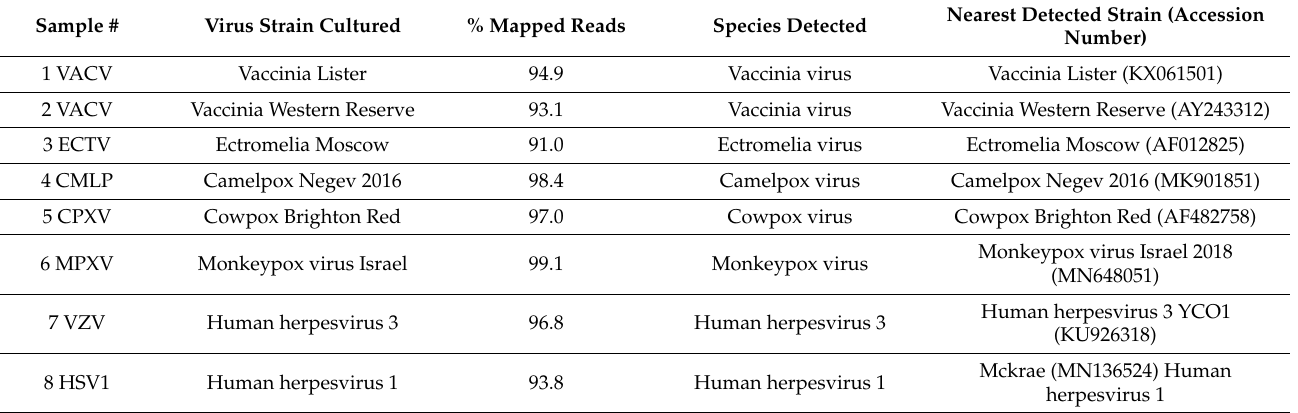
Table 3. RANS laboratory samples’